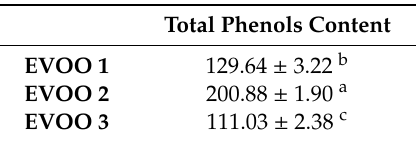
Table 1. Total phenol contents in three di ff erent extra-virgin olive oils (EVOOs) (mg kg − 1 fresh weight (FW)). Di ff erent letters represent di ff erences following one-way ANOVA, Bonferroni post-test p < 0.05. Data represent means ± standard deviation of three